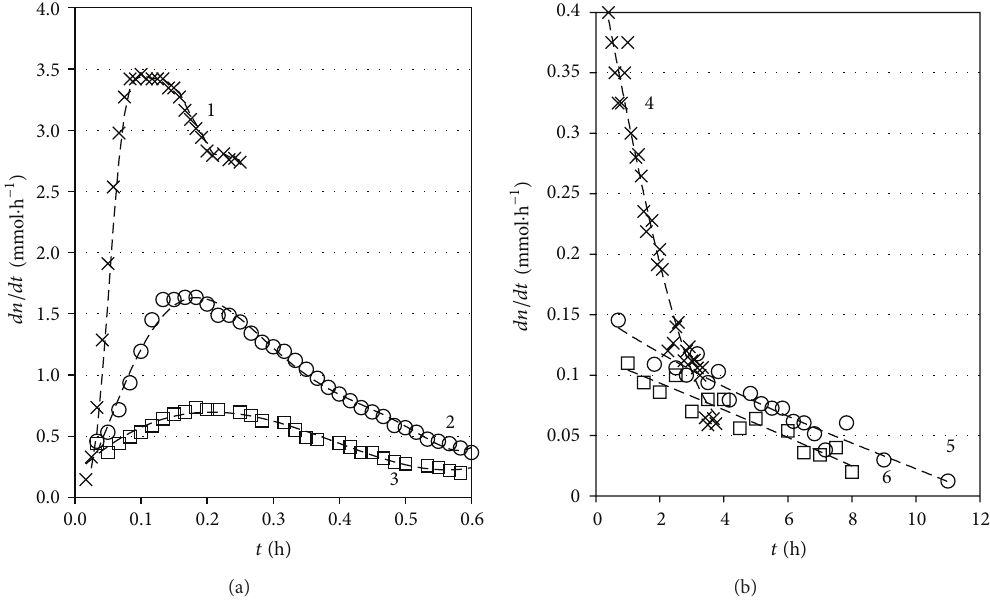
Figure 6: Solvent rates of transfer dependences 𝑑𝑛 𝐿 /𝑑𝑡 as a function of elapsed time 𝑡 for the three solute concentrations: (a) constant volume regime: (1) 0.5 M; (2) 0.2 M; (3) 0.1M ( 𝑛 𝐿 is expressed in millimoles); (b) variable volume regime: (4) 0.5 M; (5) 0.2M; (6) 0.1M ( 𝑛 𝐿 is expressed in moles). Table 2: Comparison of the kinetic characteristics of the osmotic process in aqueous sucrose solutions for the two experimental regimes of constant and variable solution volume. Active area of the semipermeable membrane 𝑆 𝑀 = 4.65 cm 3 . Studied solution (concentration/experimental regime) 0.1mol/L 0.2 mol/L 0.5 mol/L (Constant/varied) (Constant/varied) (Constant/varied) 𝑑𝑃/𝑑𝑡 [ mbar/s ] 1.306 0.044 2.94 0.15 6.22 0.52 𝑑𝑛/𝑑𝑡 [ mmol/m 2 s ] 0.448 0.107